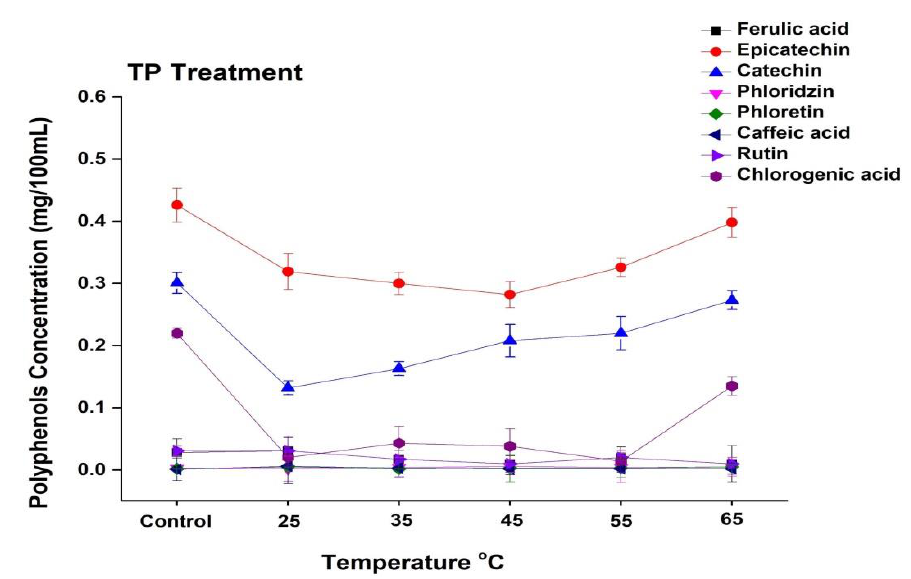
Figure 5. Changes in the phenolic profile of apple juice subjected to thermal treatment (25–65 °C) for 20 min. Data presented as the mean ± SD (standard deviation).